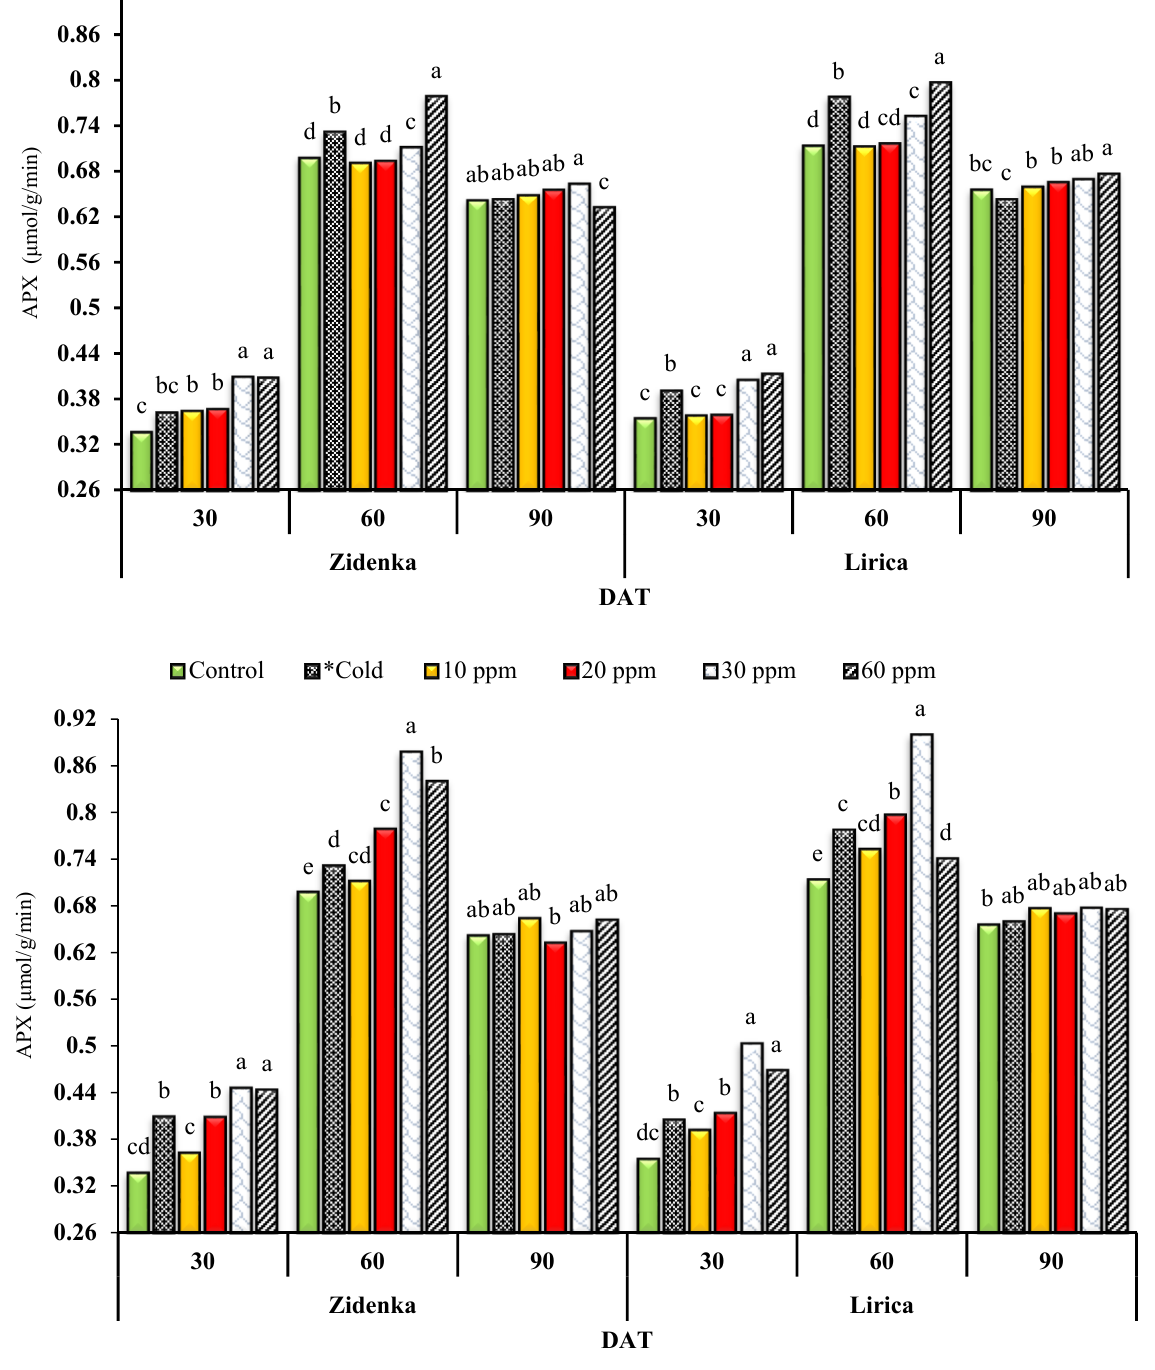
Figure 5. Effect of seedlings spray with different ozonated water concentrations and cold pretreat- ments on APX activity of two pepper hybrids 30, 60, and 90 days after transplanting during the 2017/2018 ( upper figure) and 2018/2019 ( lower figure) seasons. Columns labeled with a lowercase letter are not significantly different according to Duncan’s multiple range test at 0.05 levels for the same sampling date in each season and each hybrid separately. * Cold stress treatment was performed at 4 ◦ C for 36 h. Ozonated water applied as seedling spray compared to the untreated control. The average value of three biological and three technical replicates is reported.